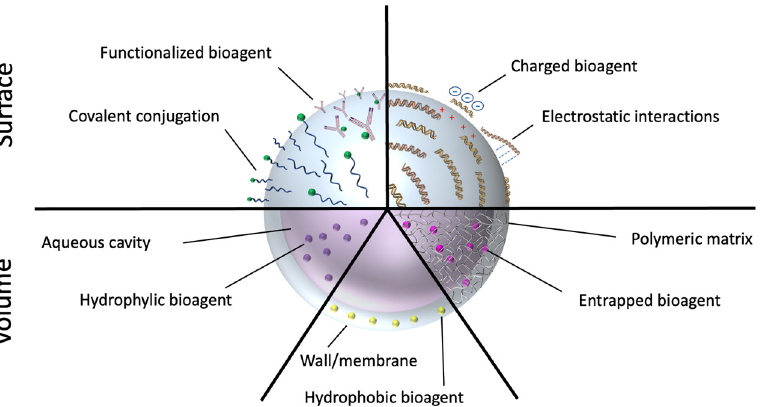
Figure 2. Drug loading on drug delivery platforms. Drugs can be loaded onto nano- and microcar- riers via attachment to the surface or incorporated into the whole carrier volume. Bioagents can be covalently or non-covalently conjugated to the surface, or entrapped into the internal cavities or the constituent materials of the particles.